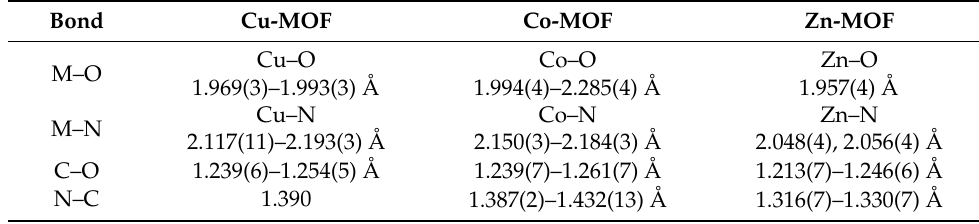
Table 2. Selective bond lengths for the Cu-MOF, Co-MOF, and